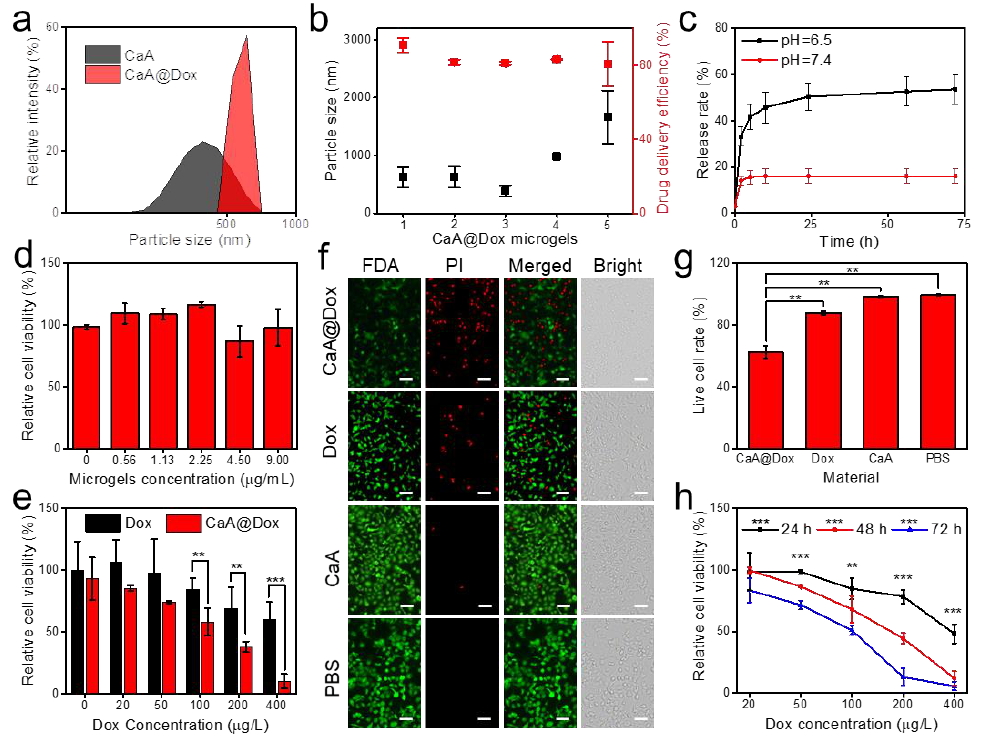
Figure 5. 3D-printed concentration-controlled microfluidic chip for Dox delivered CaA